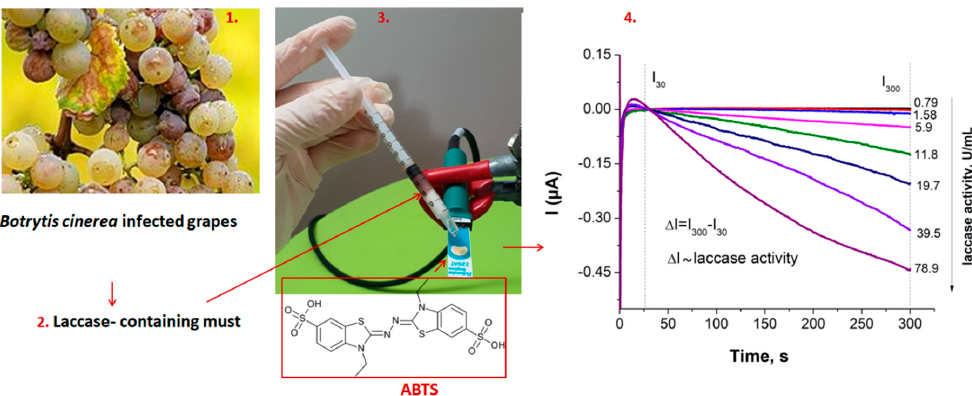
Figure 3. Principle of measuring the activity of laccase in must with SPAuEs: laccase-containing must obtained from Botrytis cinerea -infected grapes is filtered through a PVPP cartridge to eliminate phenolic compounds; then, it is mixed with ABTS on the surface of a SPAuE. The oxidized ABTS formed in the laccase-catalyzed reaction (i.e., ABTS . + ) is reduced on the electrode at 0 V vs. Ag / AgCl and the di ff erence in the cathodic current recorded at 300 s and 30 s ( ∆ I) is proportional to laccase activity in the must.